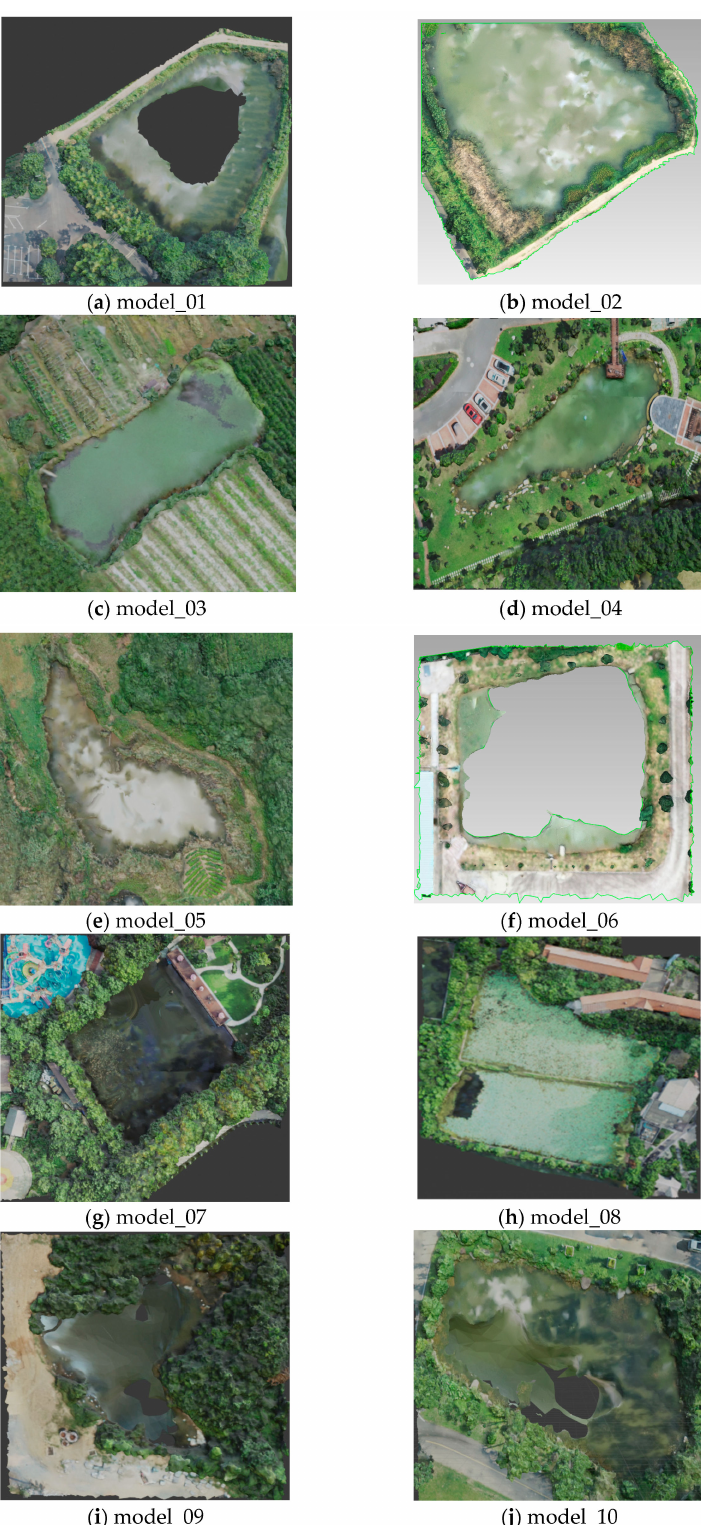
Figure 5. The experimental 3D models of oblique